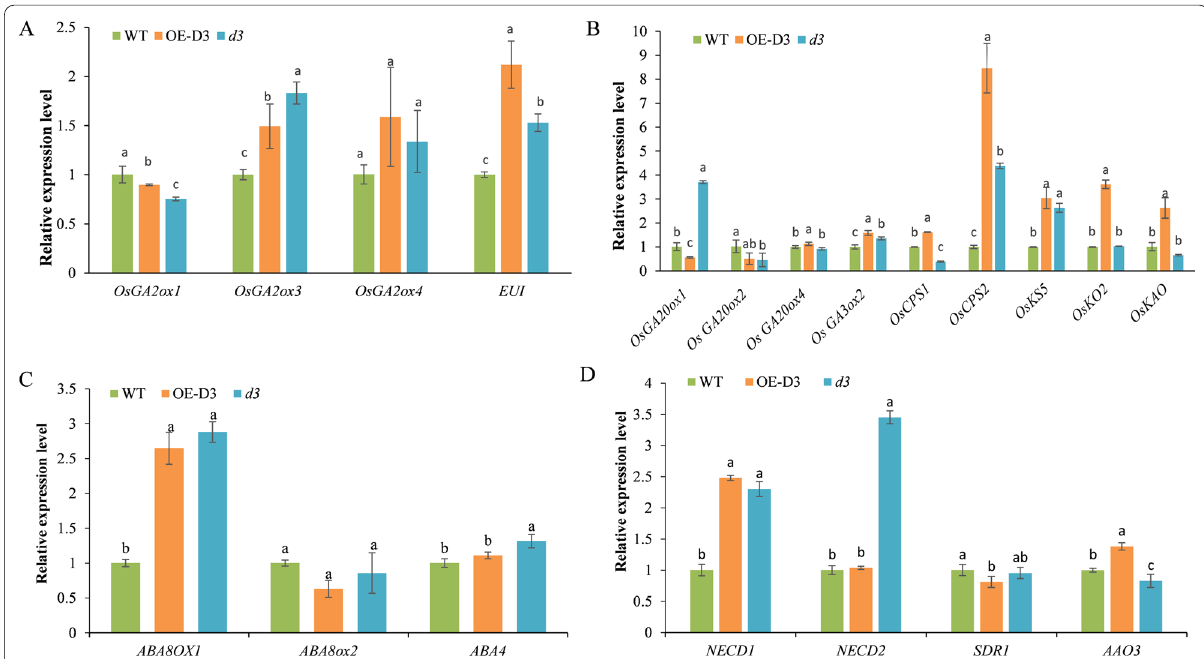
Fig. 6 Expression analysis of some key genes involved in GA and ABA degradation and biosynthesis in WT, OE-D3 and d3 lines. A Expression analysis of GA degradation-related genes. B Expression analysis of GA biosynthesis-related genes. C Expression analysis of ABA degradation-related genes. D Expression analysis of ABA biosynthesis-related genes. Data are presented as the means gene was used as an internal control. The relative expression level was calculated by the 2 − ΔΔCT